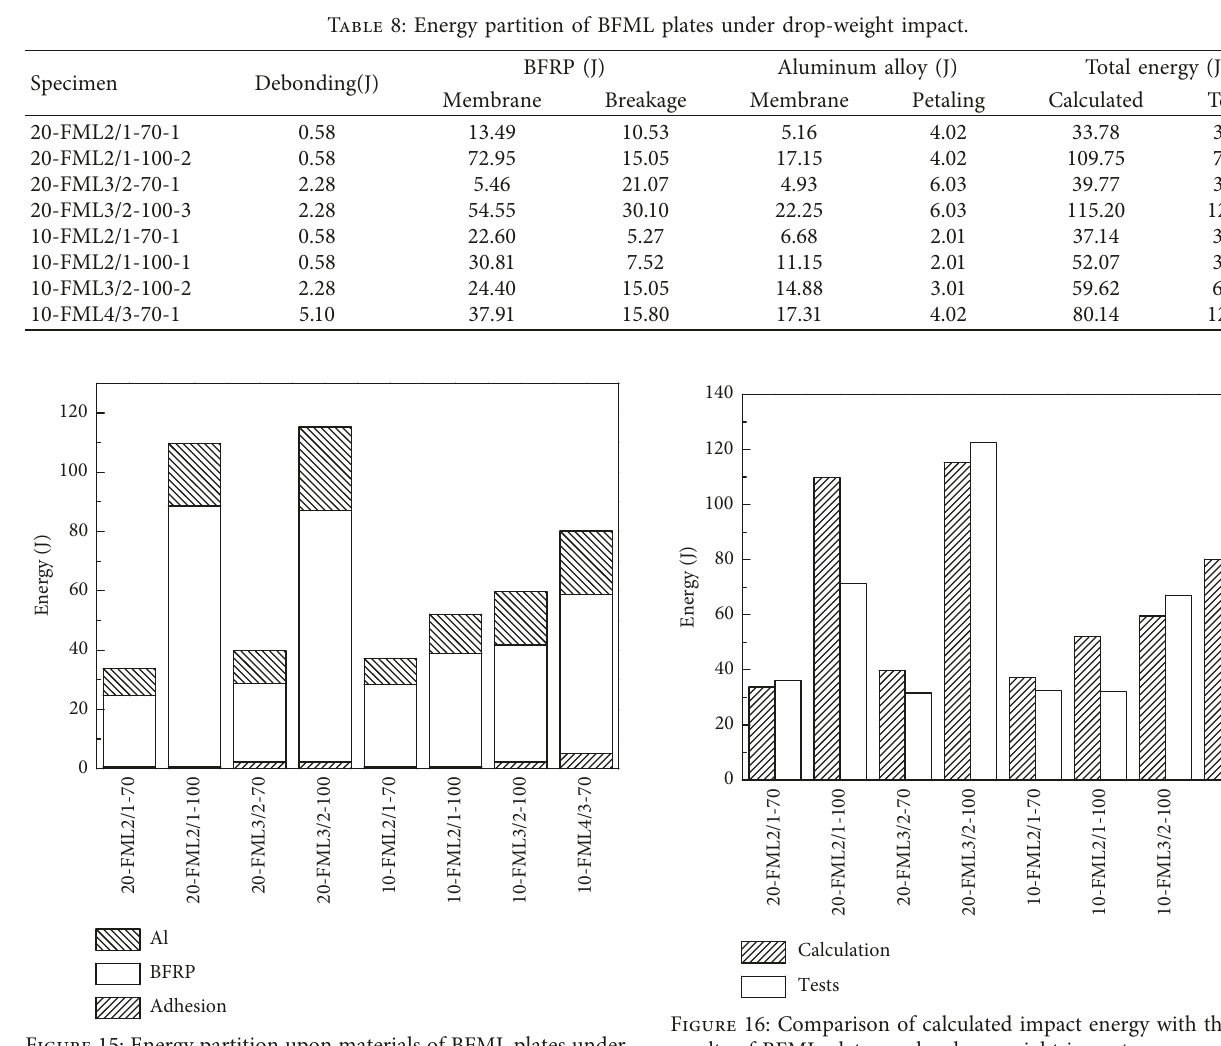
Figure 15: Energy partition upon materials of BFML plates under drop-weight impact.